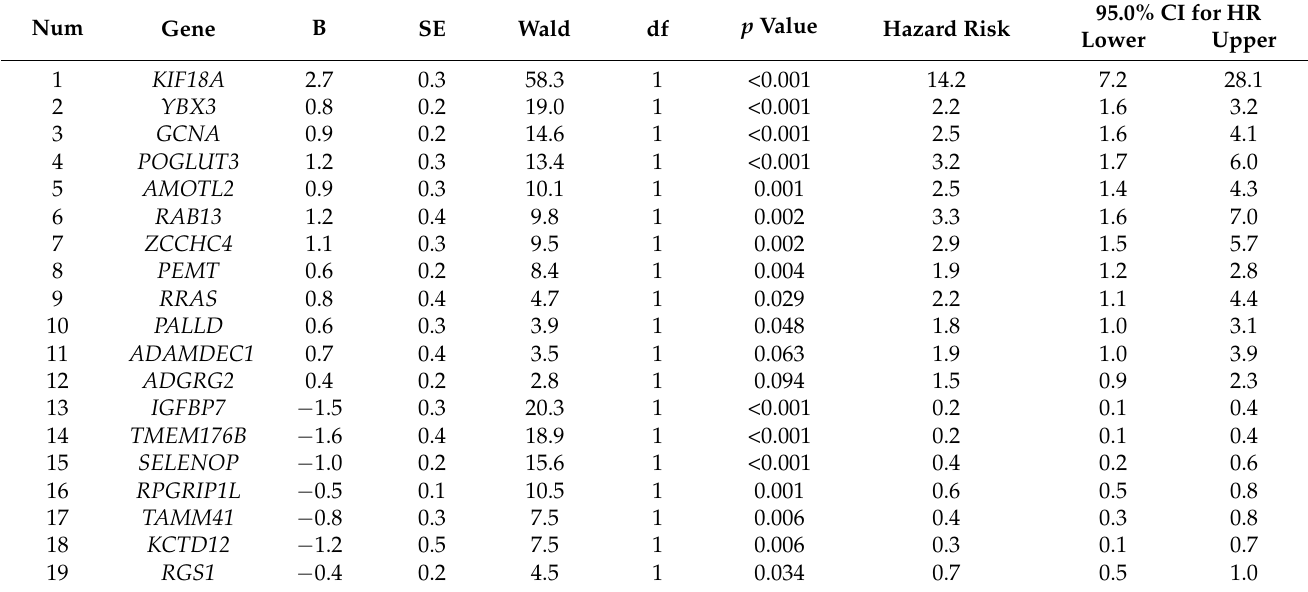
Table A3. Multivariate Cox regression analysis for predicting overall survival outcome (Method 1).